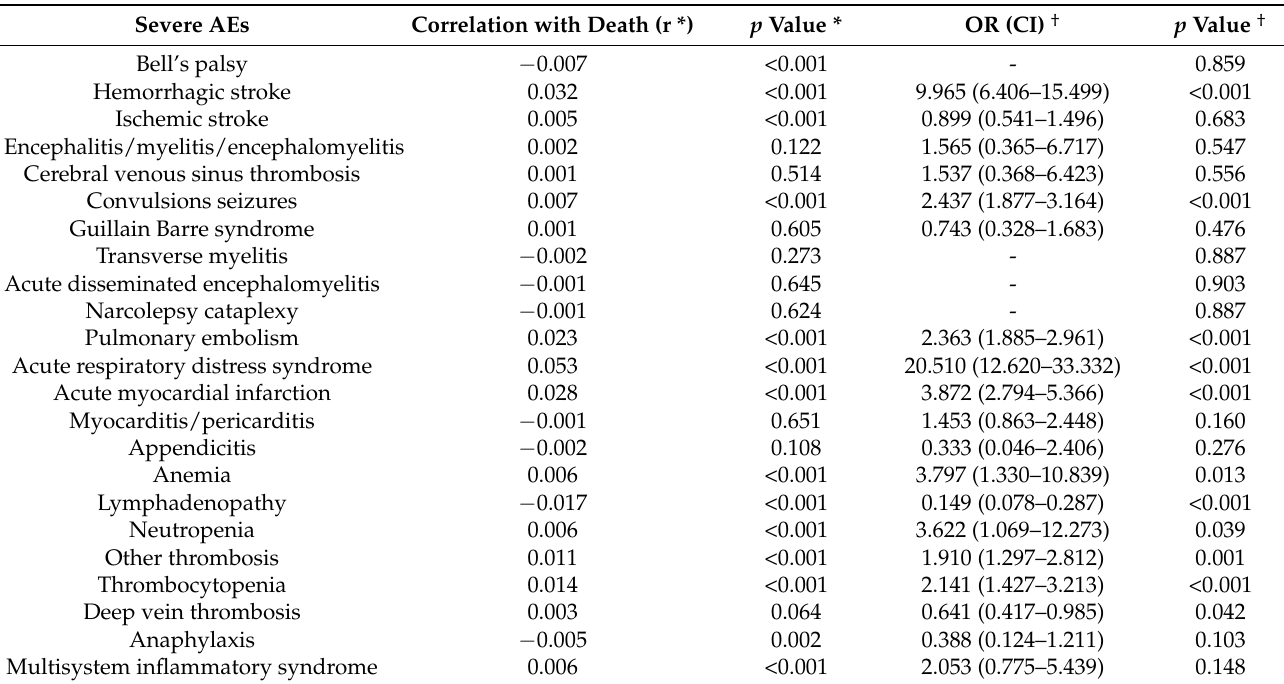
Table 4. Correlation analysis and multivariate logistic regression analysis between death and se- vere